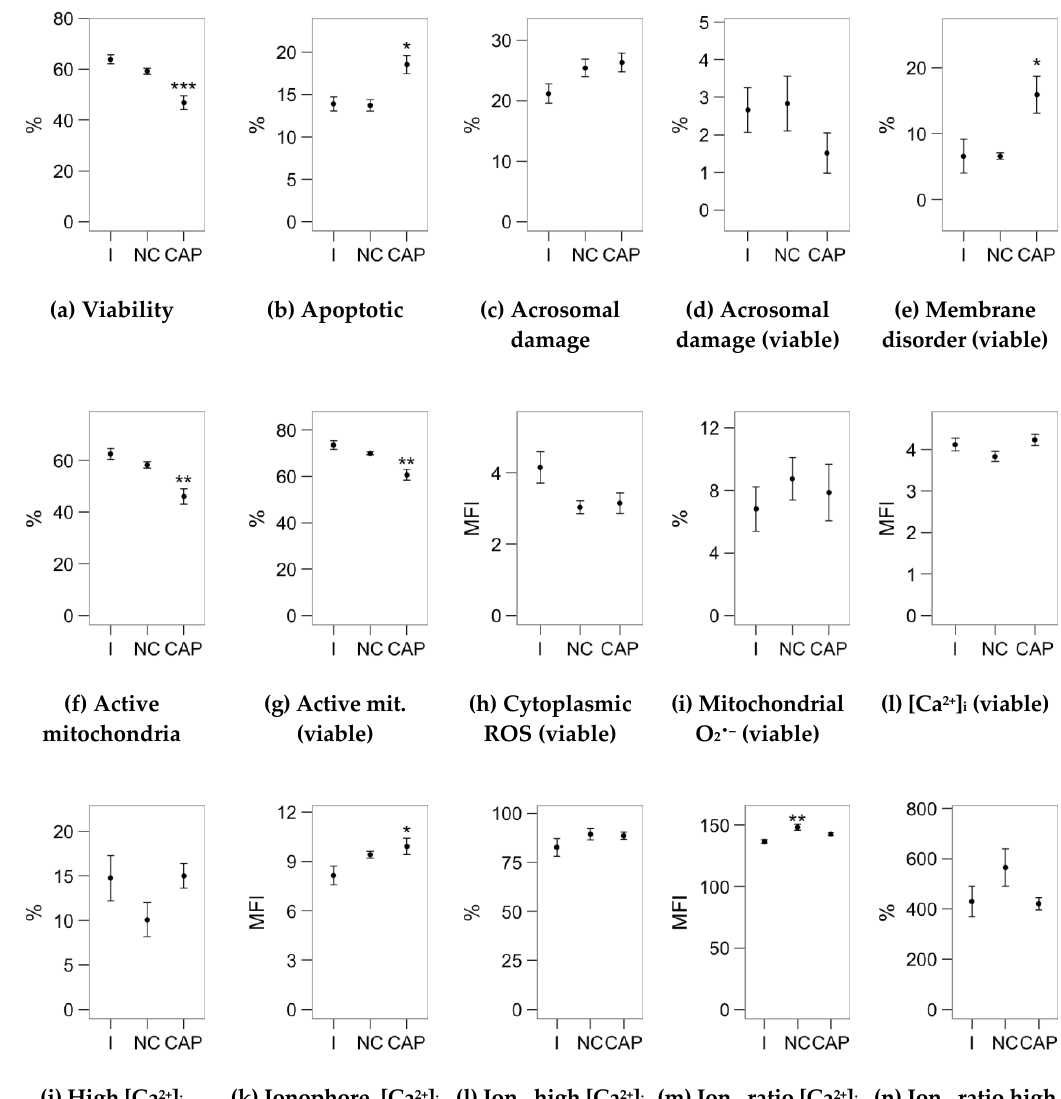
Figure 2. Results of sperm analyses (sperm physiology by flow cytometry) in the unprocessed samples (initial assessment, I) and after the incubation (4 h at 37 °C and 5% CO 2 ) in non-capacitating (NCAP) and capacitating (CAP, 2 UI/mL heparin) conditions. Plots show mean s± SEM. ( a ) Viable